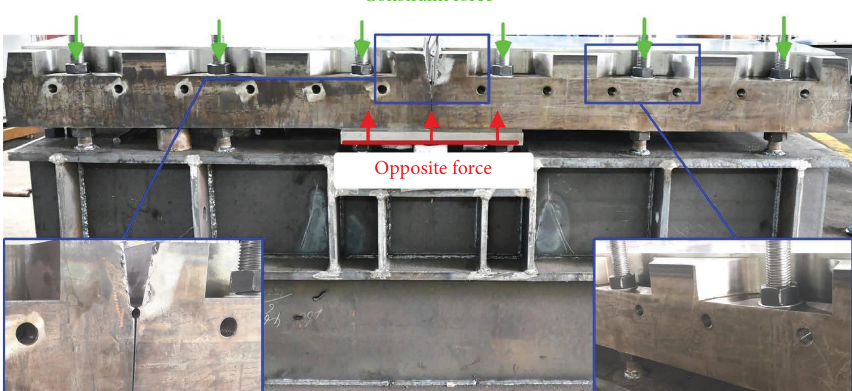
Figure 4: Leveling and opposite deformation of the antenna’s azimuth track. Table 1: Chemical composition of 42CrMo(4140) and J607Ni(E9015-G). Wt.%